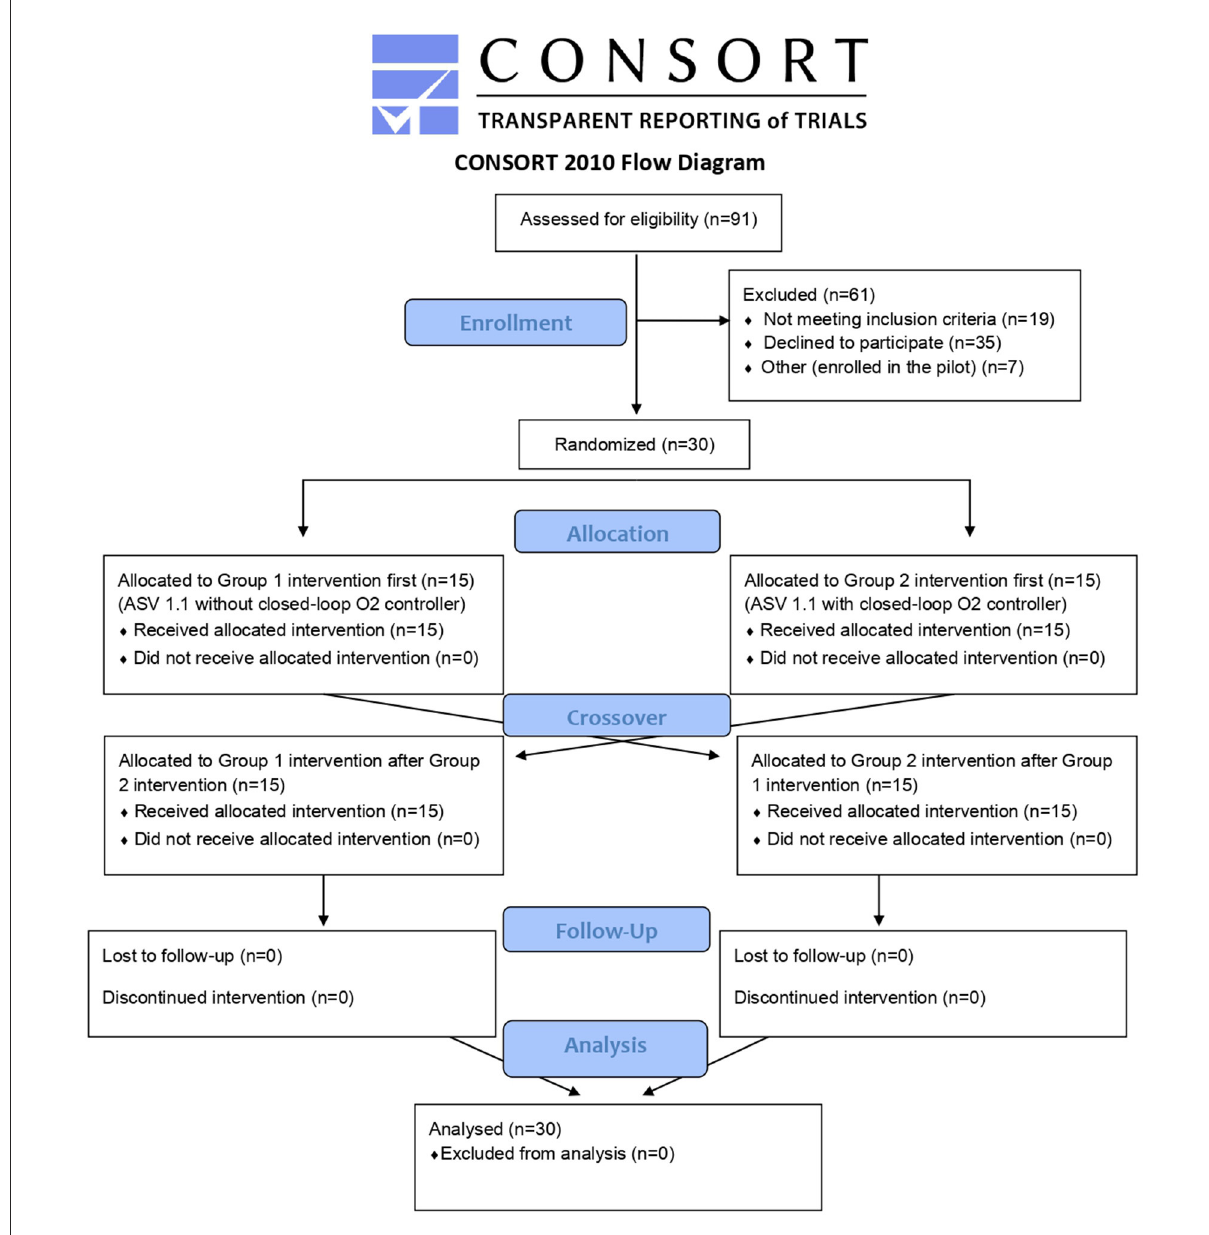
FIGURE2 Consort 2010 flow